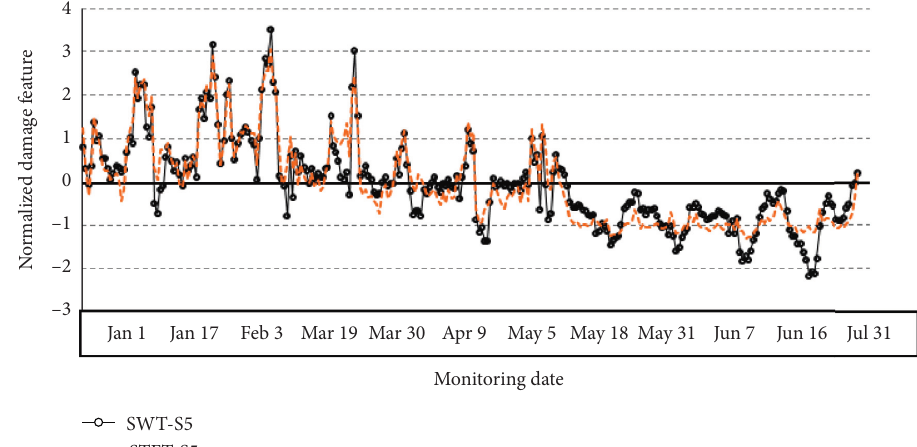
Figure 9: Normalized damage feature (S5) extracted by using STFT and SWT from healthy to damage states for the monitoring dates. Table 8: The average accuracy of different feature sets using ensemble classifiers. Ensemble techniques Feature set